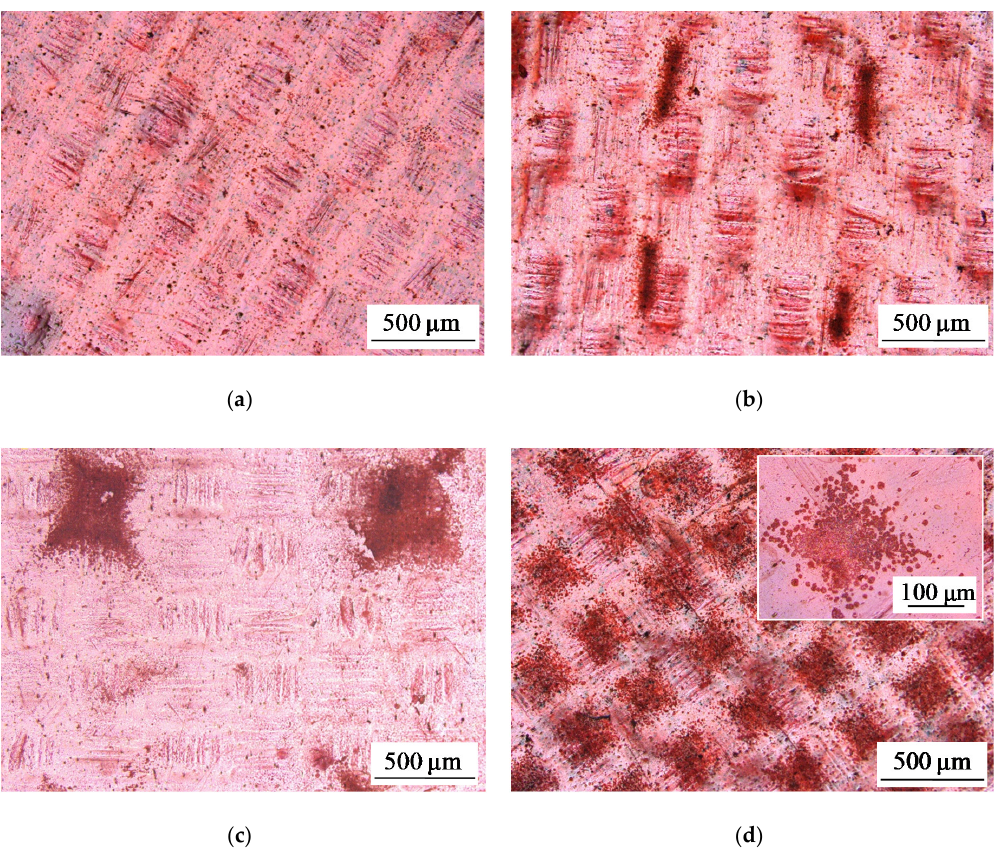
Figure 1. Optical images of the surface of swollen membrane samples: the pristine AMX-Sb membrane ( a ), and the modified AMX-Sb 1 ( b ), AMX-Sb 2 ( c ), and AMX-Sb 5 ( d ) membranes with relatively big spots of fluoropolymer